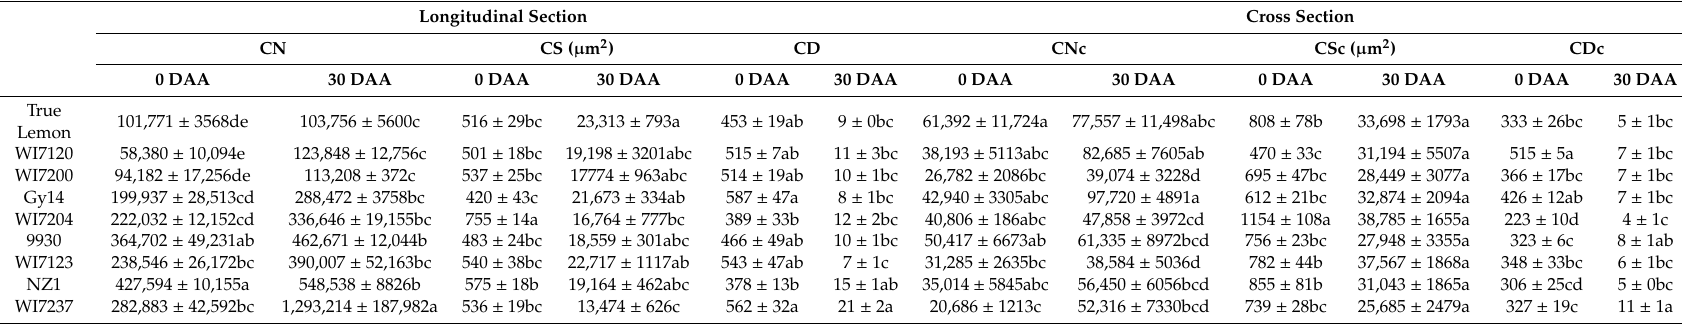
CN, CS and CD, cell number, average cell size and cell density of the longitudinal section, respectively; CNc, CSc and CDc, cell number, average cell size and cell density of the cross section, respectively; letters represent significant di ff erence at p < 0.05, Tukey’s